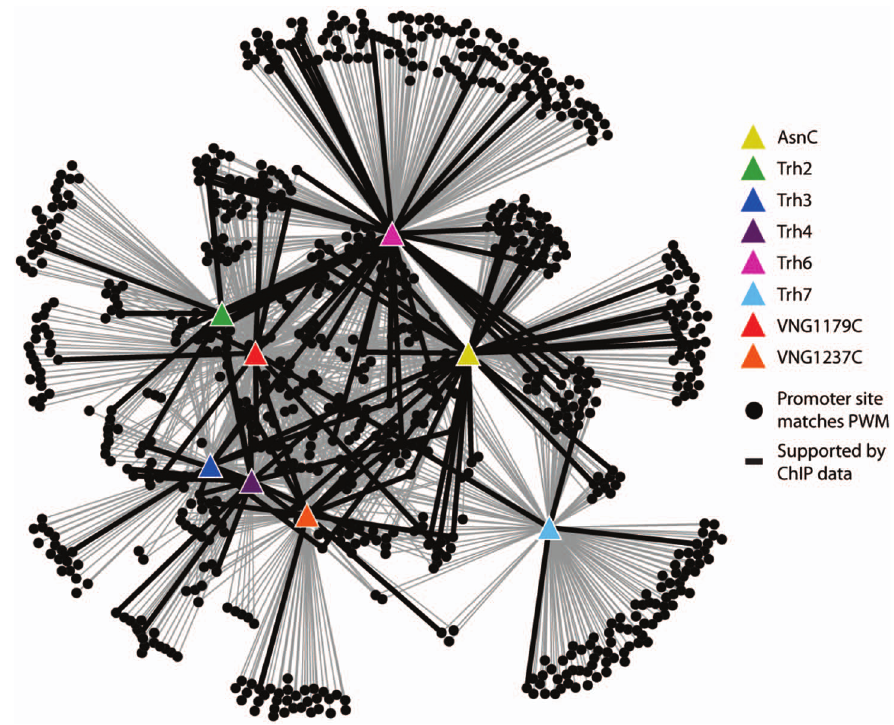
Figure 3. The set of inferred FFRP regulatory relationships in H.salinarum that is supported by structure-based prediction of FFRP transcription factor binding site preferences. Triangles are FFRP transcription factors and circles indicate genes whose promoters contain a sequence that matches a predicted PWM. Thick black lines indicate inferences that are supported by genome-wide binding measurements (ChIP).